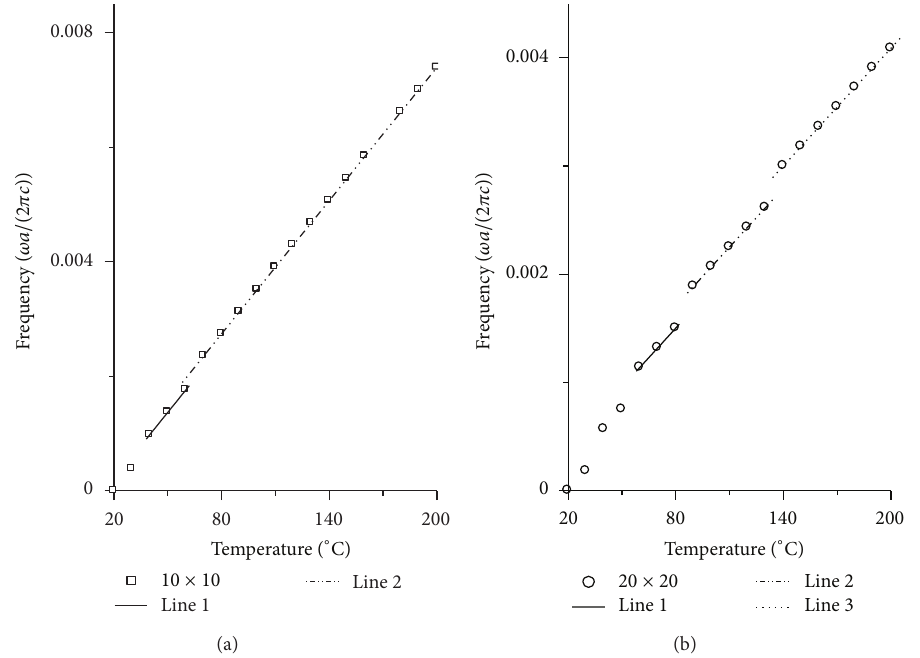
Figure 7: The shifted curves with the biggest average normalized power spectrum for 𝑛 × 𝑛 cavity, which give the relation between resonant frequency and temperature. The real lines, the dash dot line, and the dot line in (a) and (b) represent the line fit results. (a) is the result for 10 × 10 cavity. (b) is the result for 20 × 20